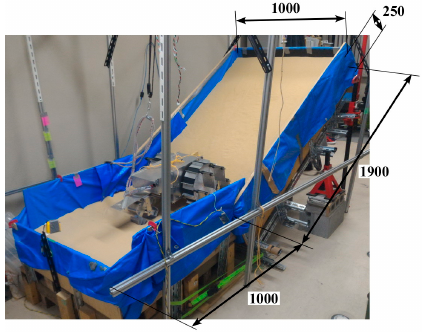
Figure 7. Indoor sand incline mobility test field with sand surface inclination set to 30